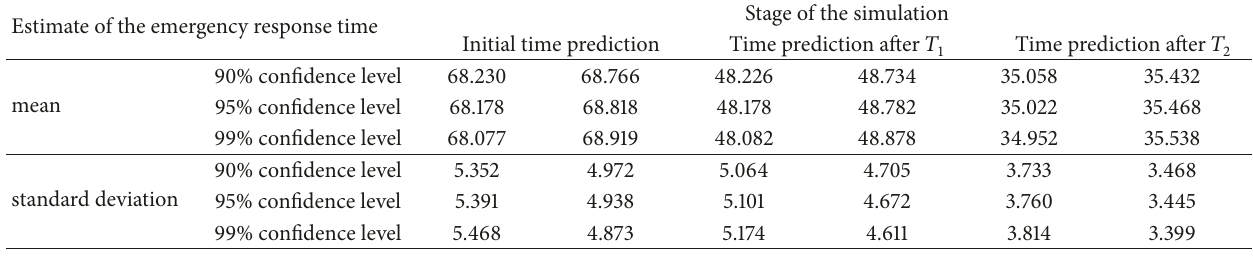
Table 4: Estimated emergency time obtained from simulation.